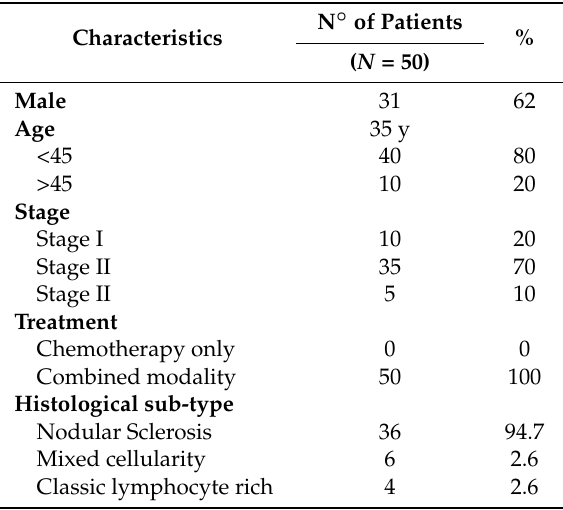
Table 1. Patient’s